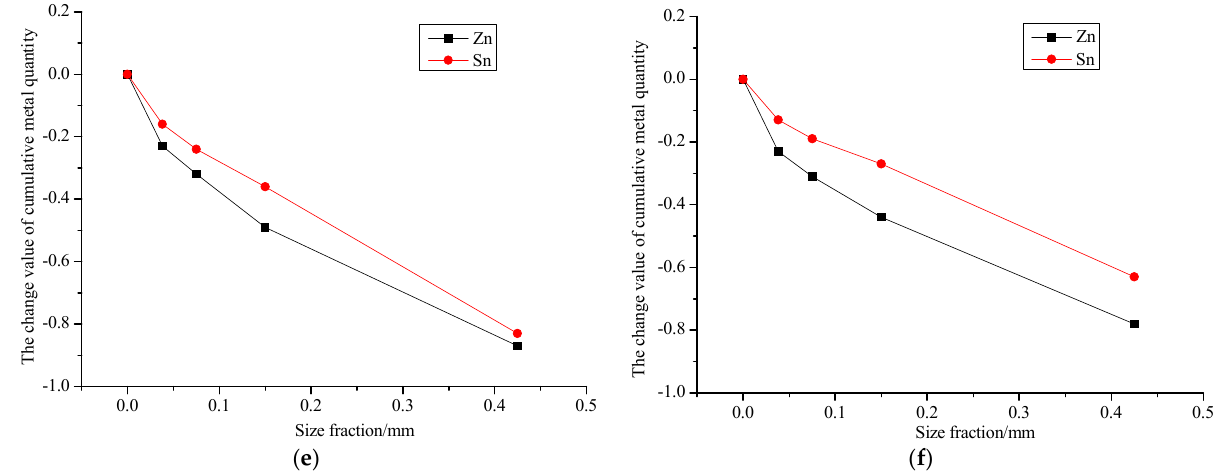
Figure 5. Changes in the cumulative quantities of metal for Zn and Sn for different size fractions and grinding concentrations. ( a ) Grinding concentration is 30%. ( b ) Grinding concentration is 40%. ( c ) Grinding concentration is 50%. ( d ) Grinding concentration is 60%. ( e ) Grinding concentration is 70%. ( f ) Grinding concentration is 80%. Table 7. Analyzing the changes in the cumulative quantities of metal for different grinding concen- trations.